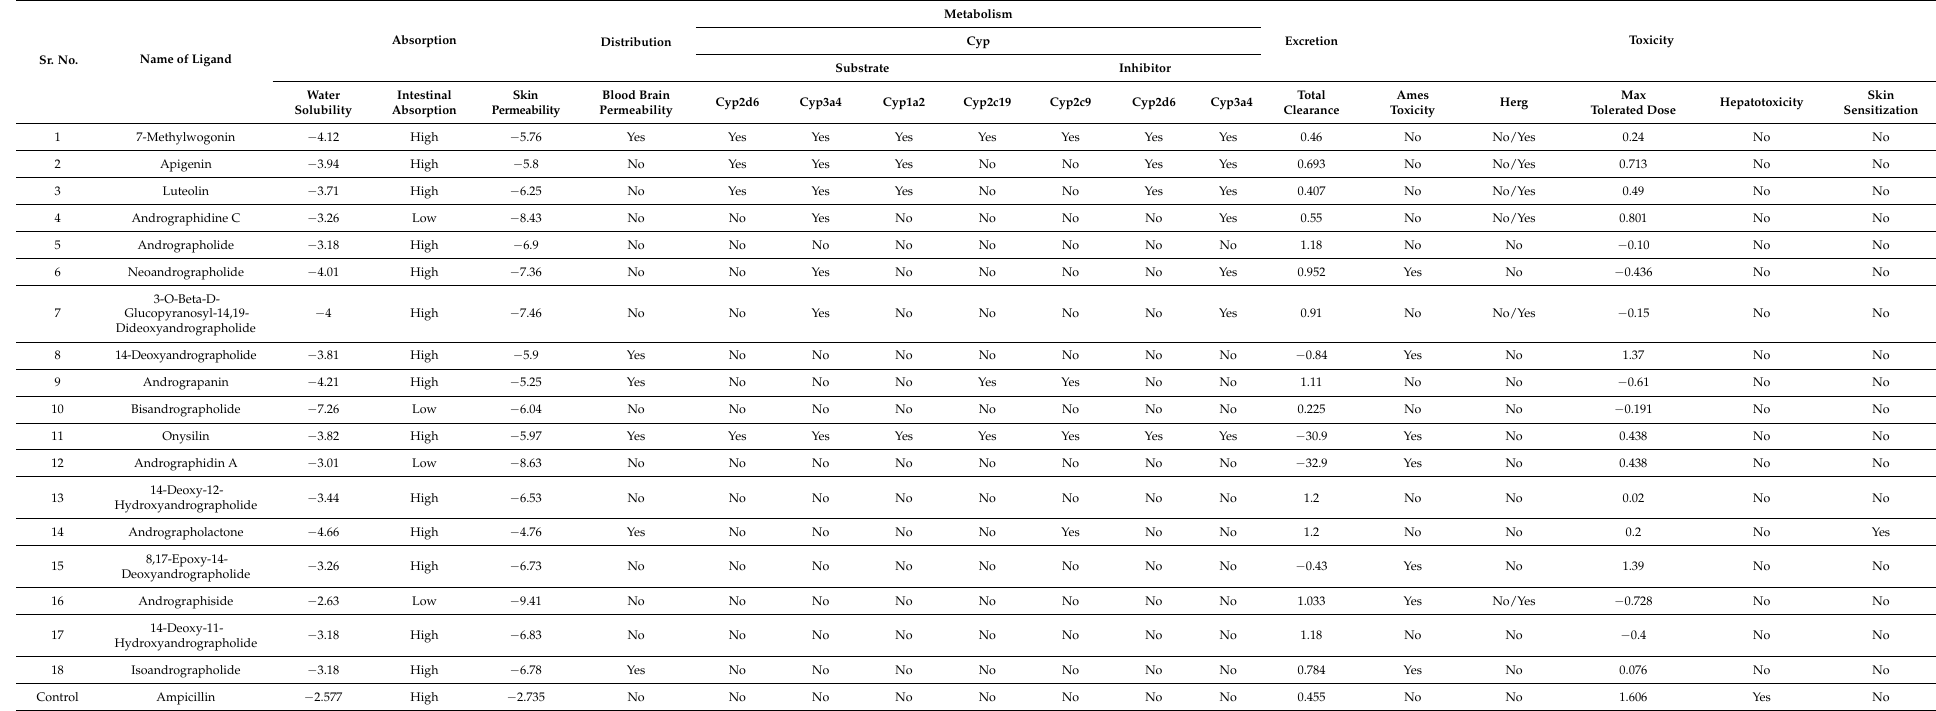
Table 4. ADMET properties of